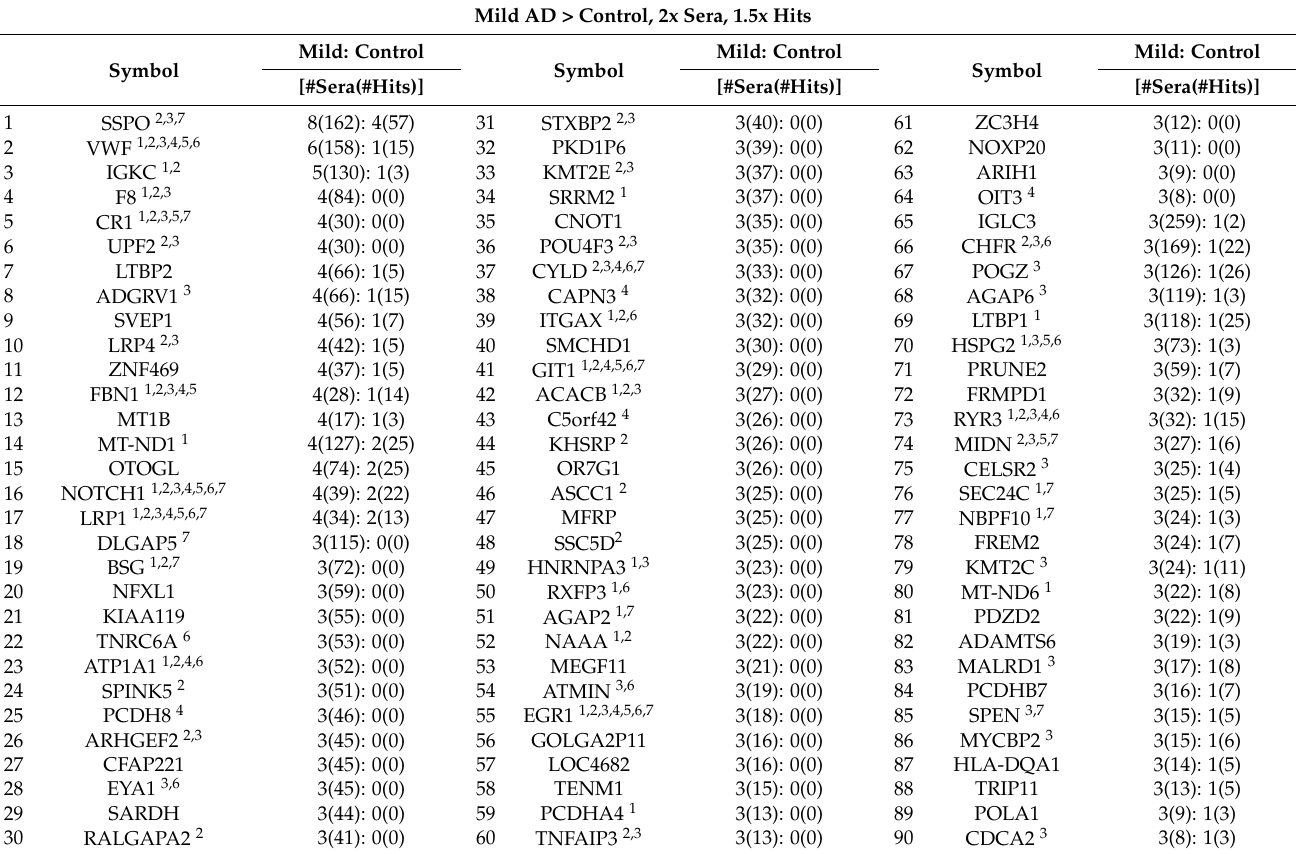
Table 3. Top 90 peptides/proteins from the mild AD > greater than control subjects with 2x or better sera differences and 1.5x or better MS/MS “hit” numbers. Mild AD > Control, 2x Sera, 1.5x